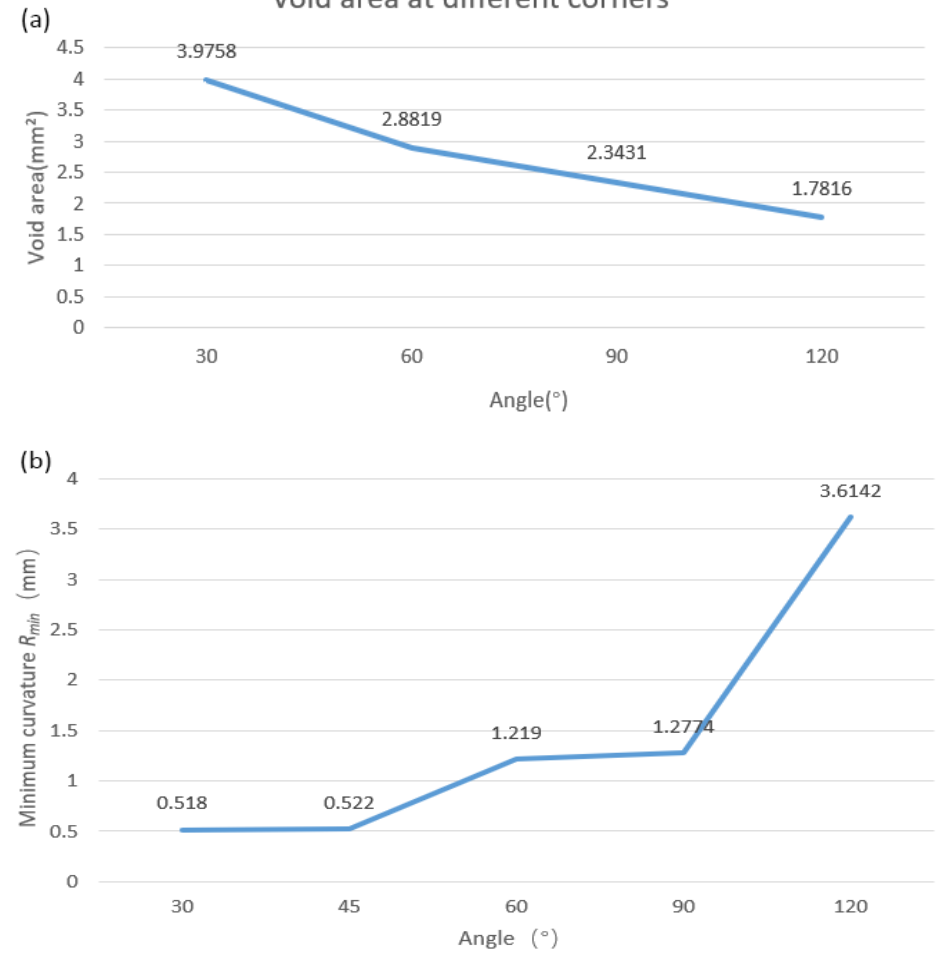
Figure 6. Actual track result, ( a ) void area change curve with angle, ( b ) schematic diagram of the minimum curvature R min at the corner changing with the angle.